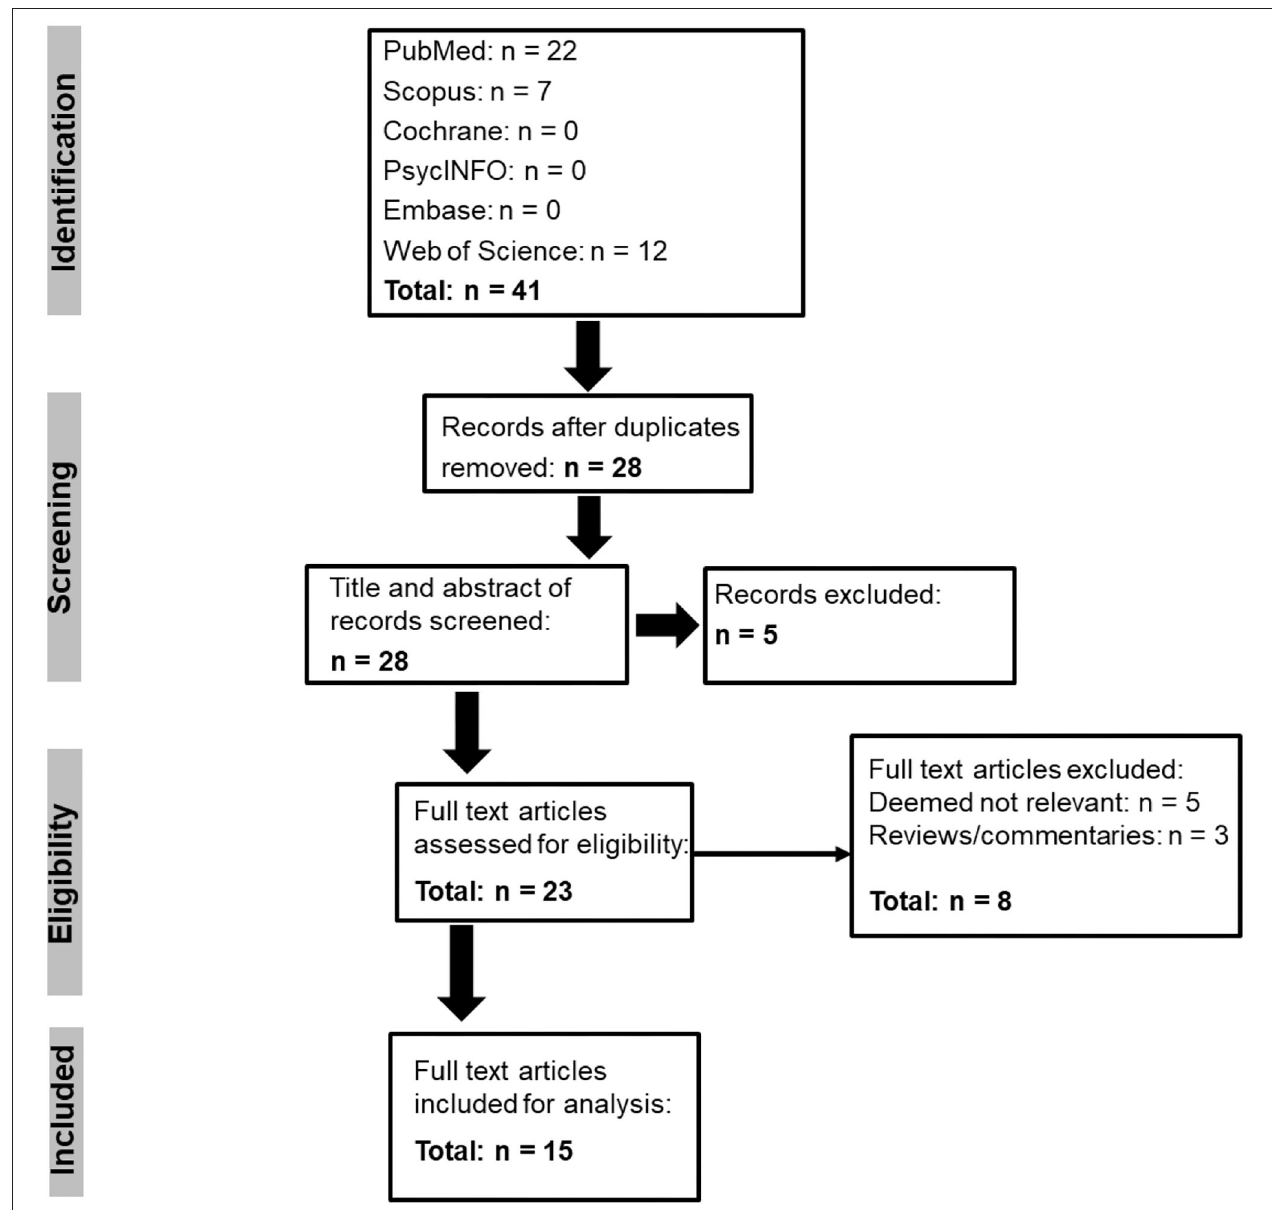
FIGURE 1 | PRISMA